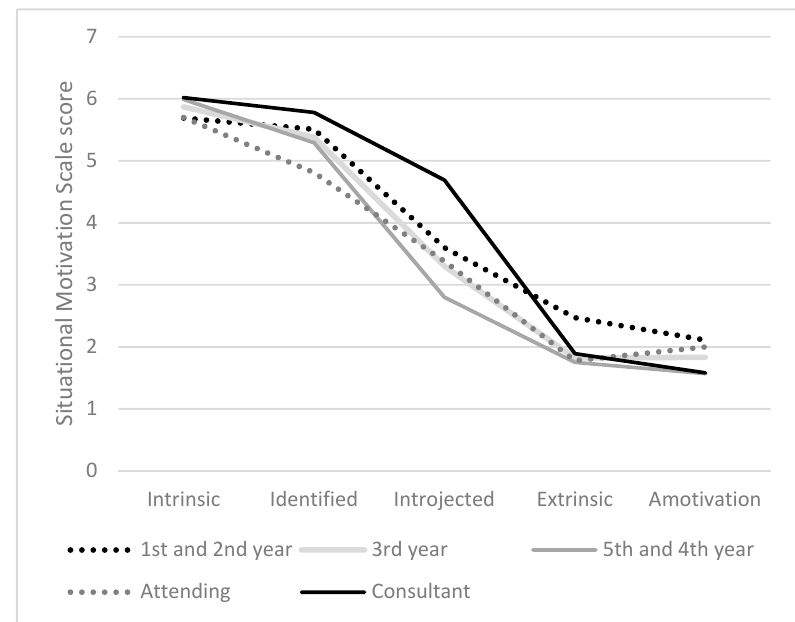
Figure 1. Patterns of motivation reported by the